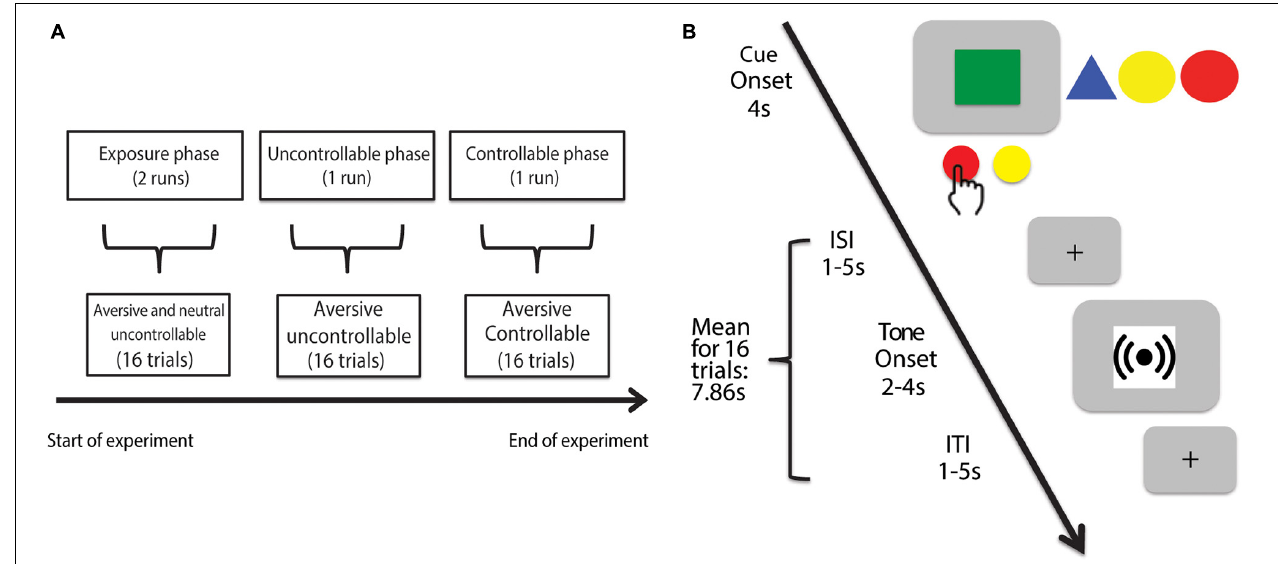
FIGURE 1 | Experimental timeline of Control in Aversive Domain (CAD) task. (A) The CAD task consisted of three phases. The first phase comprised the exposure trials where participants responded to uncontrollable cues paired with either an aversive (4,000 Hz) or neutral (500 Hz) tone. The second phase comprised the uncontrollable trials where participants experienced a series of uncontrollable aversive tones (4,000 Hz) represented by a different cue compared to the exposure trials. The last phase comprised the controllable trials where participants were given a series of controllable aversive tones (4,000 Hz) paired with yet another novel cue. (B) Example trial. In each trial, regardless of the experimental phase, participants were presented a cue (all experimental cues shown for completeness) displayed for 4 s. During the cue presentation for each trial, participants had the option to either press the AVOID or GIVE-UP button. By choosing to press the AVOID button, participants could try to control and avoid the associated tone. A successful AVOID button press yielded no tone presentation whereas a failed AVOID button press yielded 4 s of tone. By choosing the GIVE-UP button, participants would receive a guaranteed 2 s of the associated tone. The cue and tone periods respectively ended with a jittered interstimulus and intertrial interval signaled by a